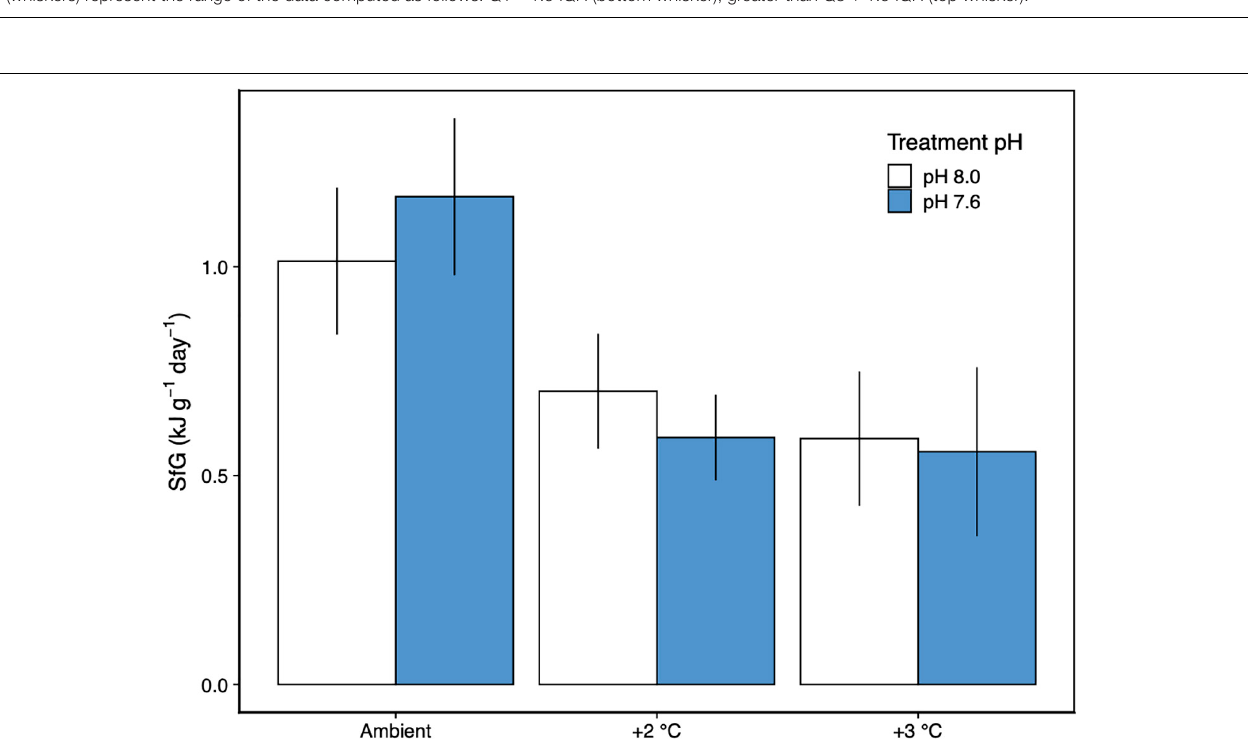
FIGURE 5 | Scope for growth ( ± SD) of H. erythrogramma acclimated to three temperature (ambient, +2 ◦ C, +3 ◦ C) and two pH T (white: 8.0, blue: 7.6) levels. The model was determined from measurements of metabolic rate, feeding rate, ammonia excretion rate and assimilation efficiency. n = 1.